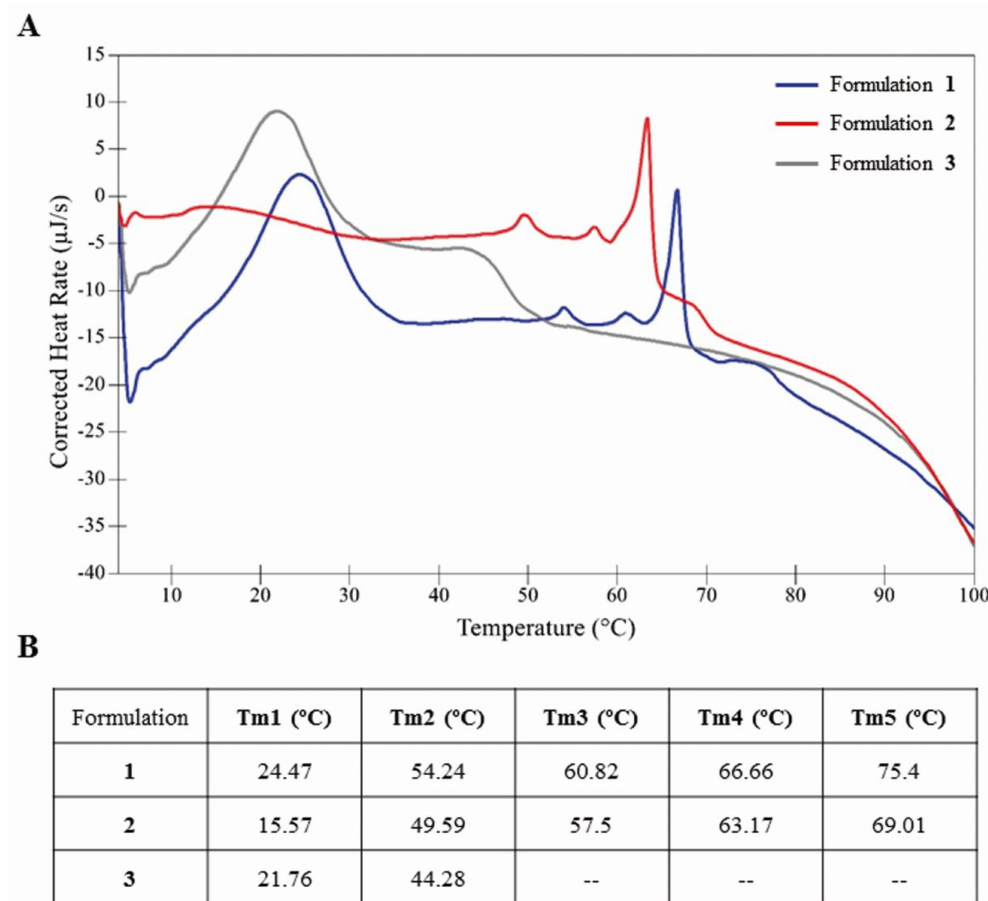
Figure 2. ( A ) Thermograms of niosomes based on formulations 1 (blue line), 2 (red line) and 3 (grey line) in aqueous solution. Scan rate: 1.0 ◦ C/1 min. ( B ) Thermal melting temperature (Tm) data for the transitions of niosome